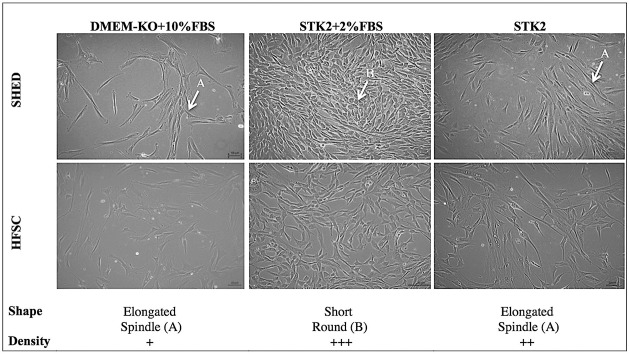
Morphology and cell density of SHED and HFSCs cultured in different media combinations.The cell morphology of SHED and HFSCs in the media combinations; DMEM-KO+10% FBS, STK2+2% FBS+STK2 at Day 3 of passage 3, observed under 10× magnification. *A- elongated spindle shape, B-short round shape, +-low cell density, ++- moderate cell density, +++- high cell density.